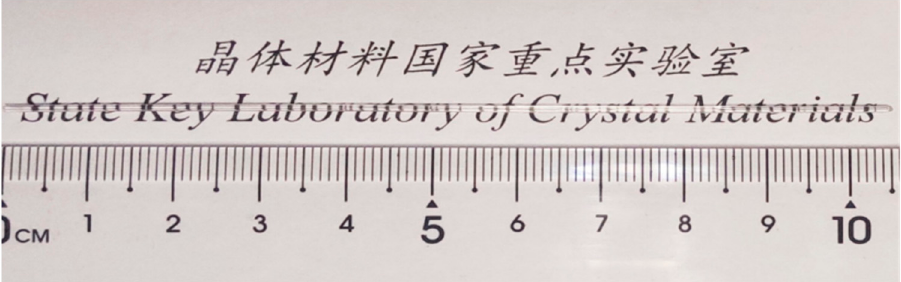
Figure 3. As-grown Yb:LuAG single-crystal fiber.